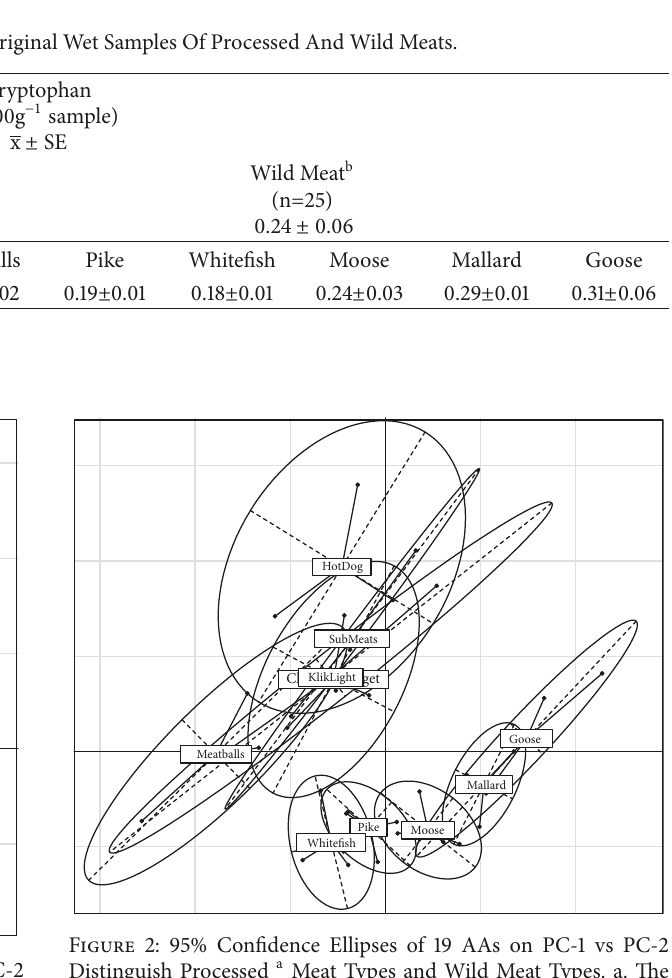
Figure 1: 95% Confidence Ellipses of 19 AAs on PC-1 vs PC-2 Distinguish Processed and Wild Meat Sources.